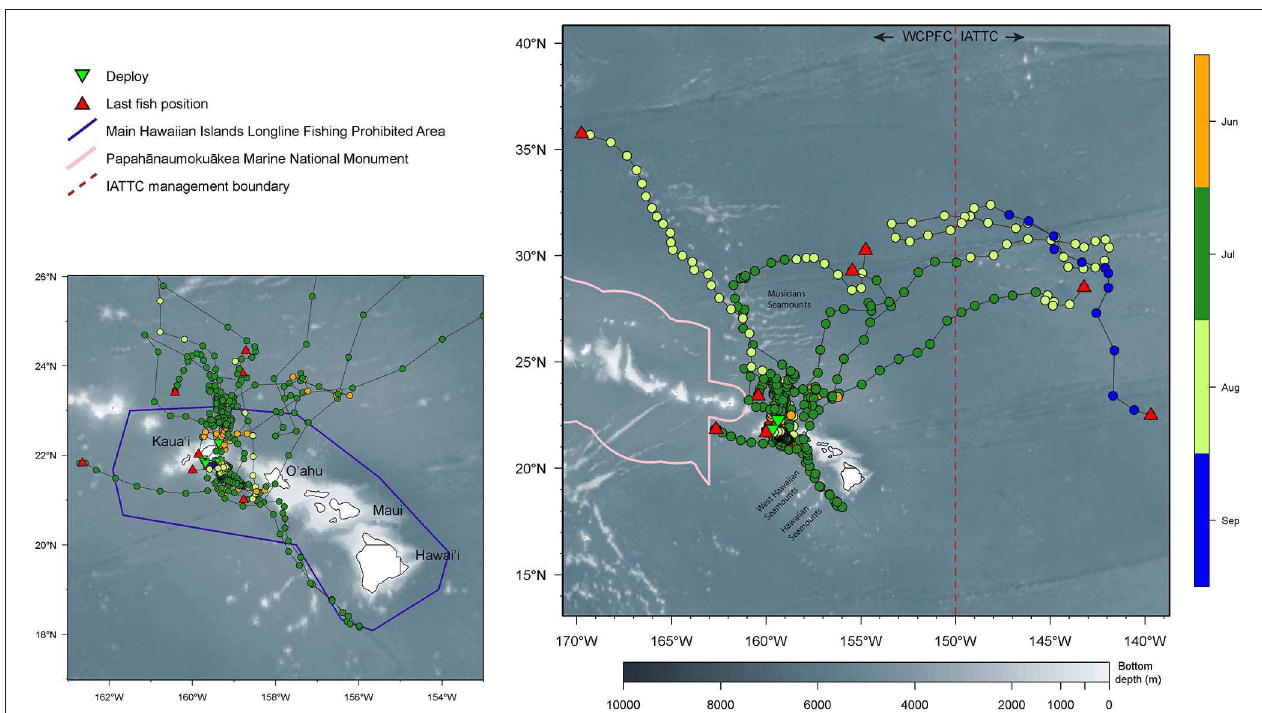
FIGURE 1 | Horizontal movements of yellowfin tuna. Smaller map provides a zoomed-in view of movements around the Main Hawaiian Islands (MHI). Positions are color-coded by months. Tagging locations, green triangle; last known fish locations, red triangle; boundary of MHI Longline Fishing Prohibited Area, purple line; boundary of the Papah ¯ anaumoku ¯ akea Marine National Monument, pink line; management boundary of Inter American Tropical Tuna Commission (IATTC), brown dashed line. Selected islands and bathymetric features are labeled for